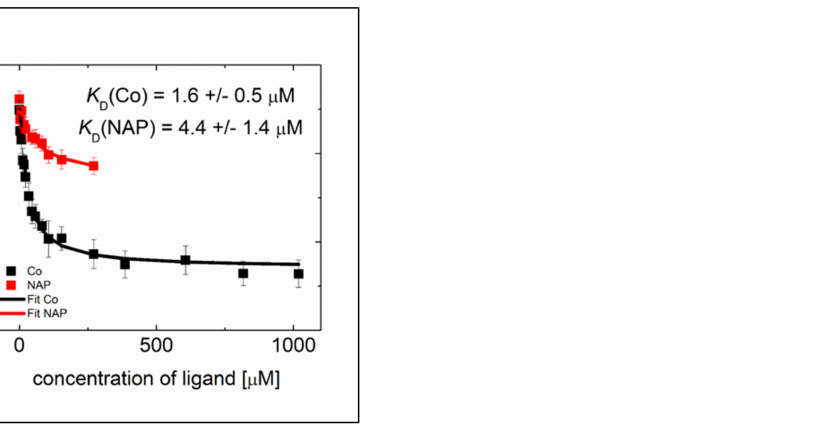
Figure 4. Competition on N NTD of binding of RNA with naproxen or naproxen C0 deduced from fluorescence anisotropy r.